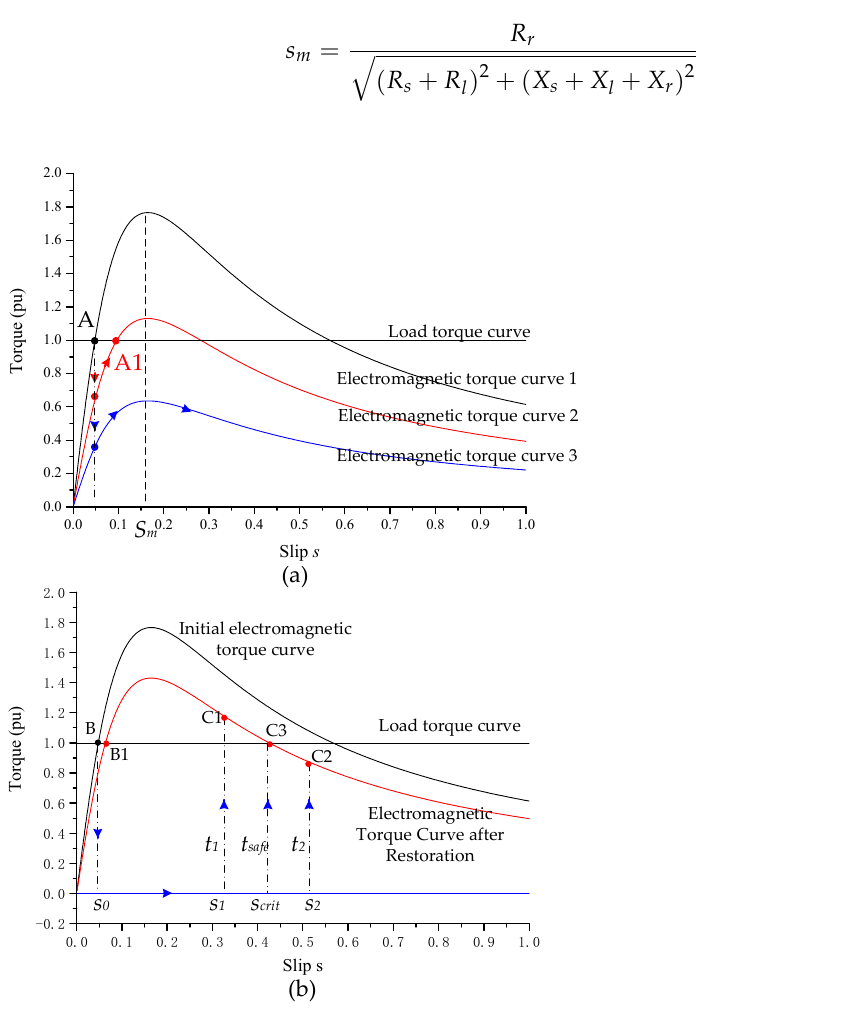
Figure 3. Diagrams illustrating two crucial parameters: ( a ) safe voltage magnitude; ( b ) te safe sag duration.